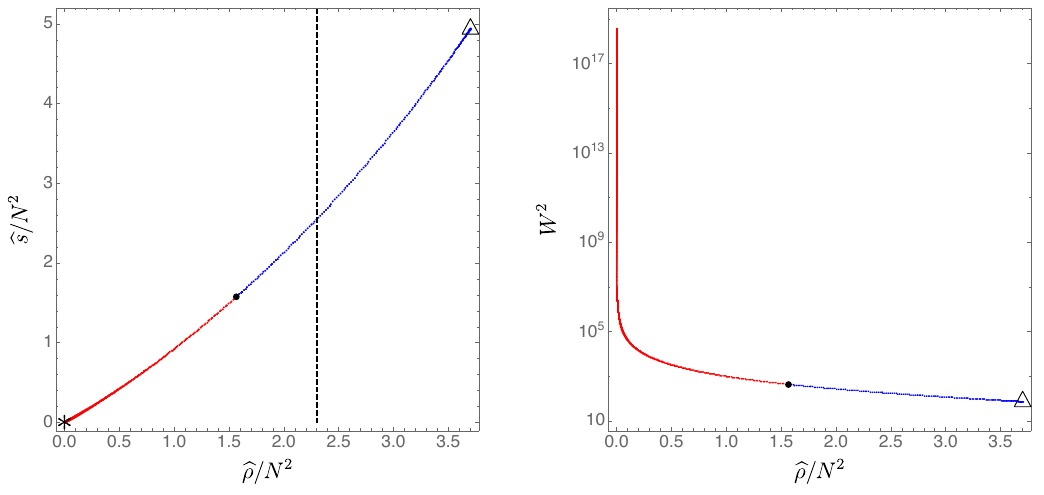
Figure 2 . Left panel: entropy density s as a function of the energy density b logarithmic plot of the Weyl curvature W 2 (cid:17) C abcd C abcd j H as a function of emerge as (cid:26) ! 0 (and m ! 0, s ! 0, i.e. as the (cid:3) solution of (cid:12)gure 1 is approached). Note that we b b b use the same color and symbol codes detailed in the caption of (cid:12)gure